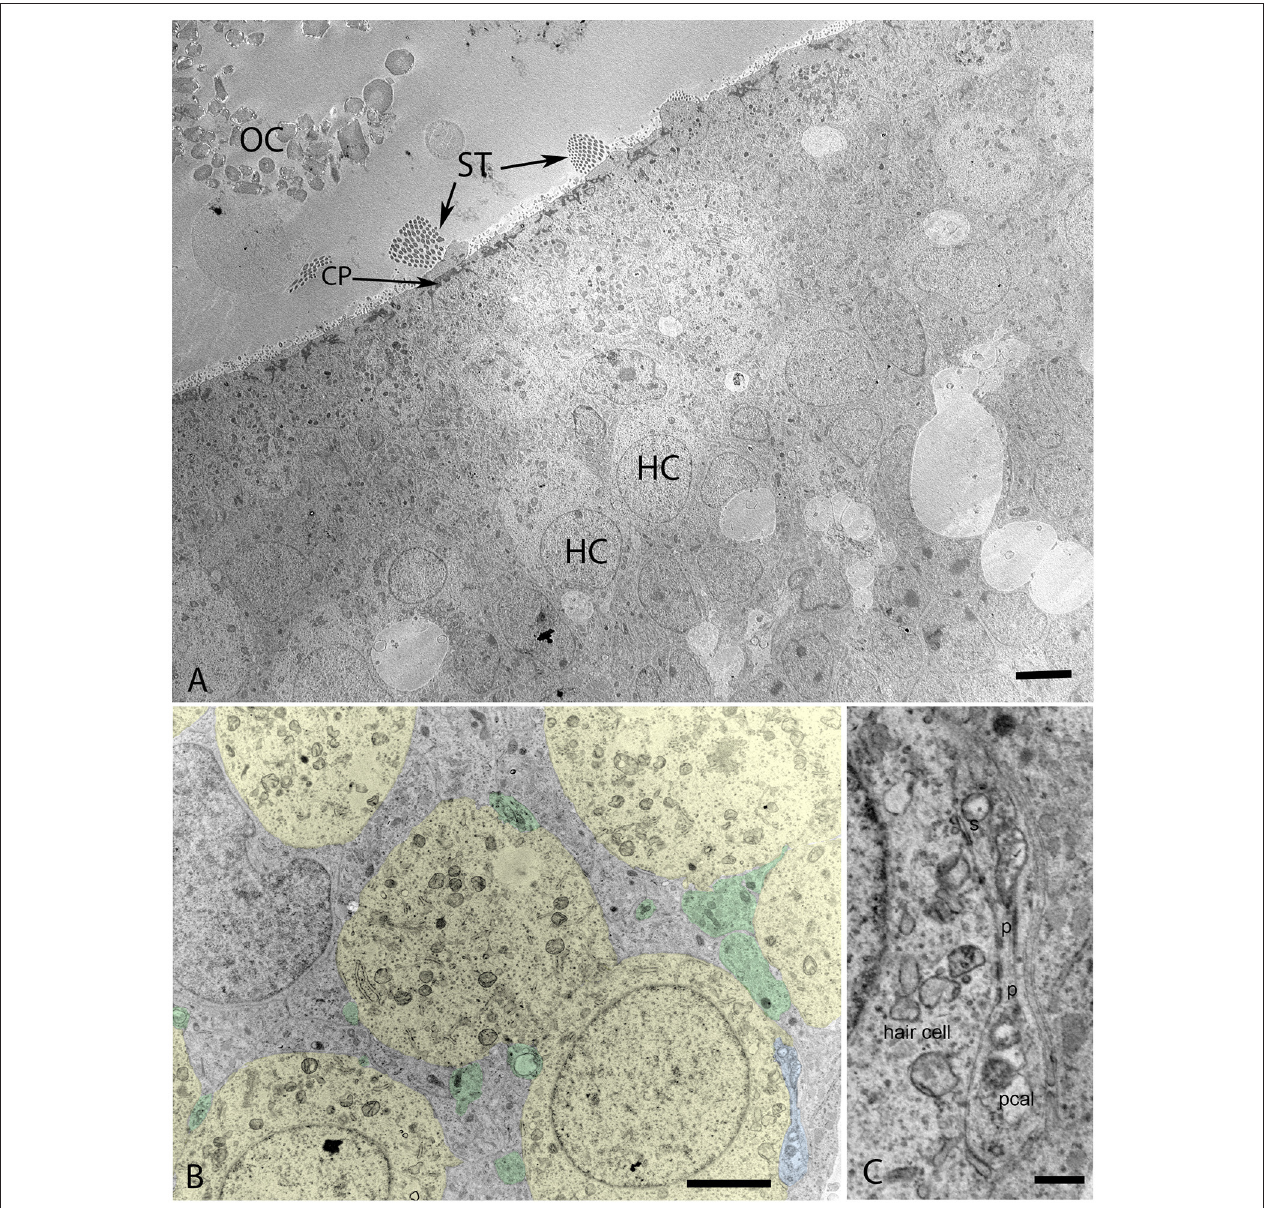
FIGURE 6 | Transmission electron micrograph of otolith organ (utricle) at W12 (A) with the hair cells (HC), stereocilia (ST), cuticular plate (CP), and immature otoconia (OC) visible. (B) Identifies the formation of the protocalyx (colored blue) visible during this stage with the somata of the vestibular hair cells (colored yellow) and embedded between supporting cells (not colored), small presynaptic terminals and nerve fibers are highlighted in green. The higher magnified view of the protocalyx (pcal) in (C) reveals synaptic contacts (s) with vesicles at the presynaptic membrane and punctum adherens contacts (p) already formed between the protocalyx and the cell body of the hair cell. Various small and bigger vesicles in the hair cell cytosol can be seen in the vicinity of this protocalyx, indicating active transport mechanisms. Scale bar: 2 µ m (A,B) , 500nm (C)